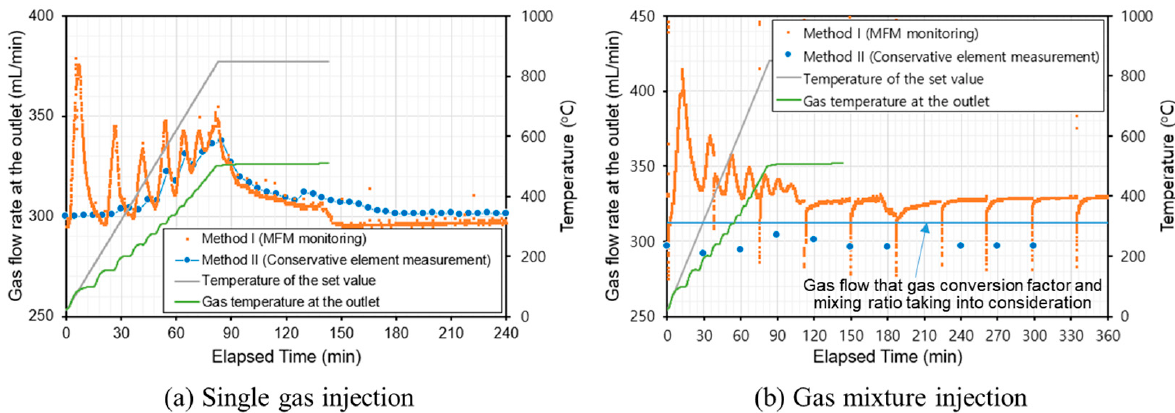
Figure 3. Comparable results for gas flow measured using Methods I and II in the different gas injection.